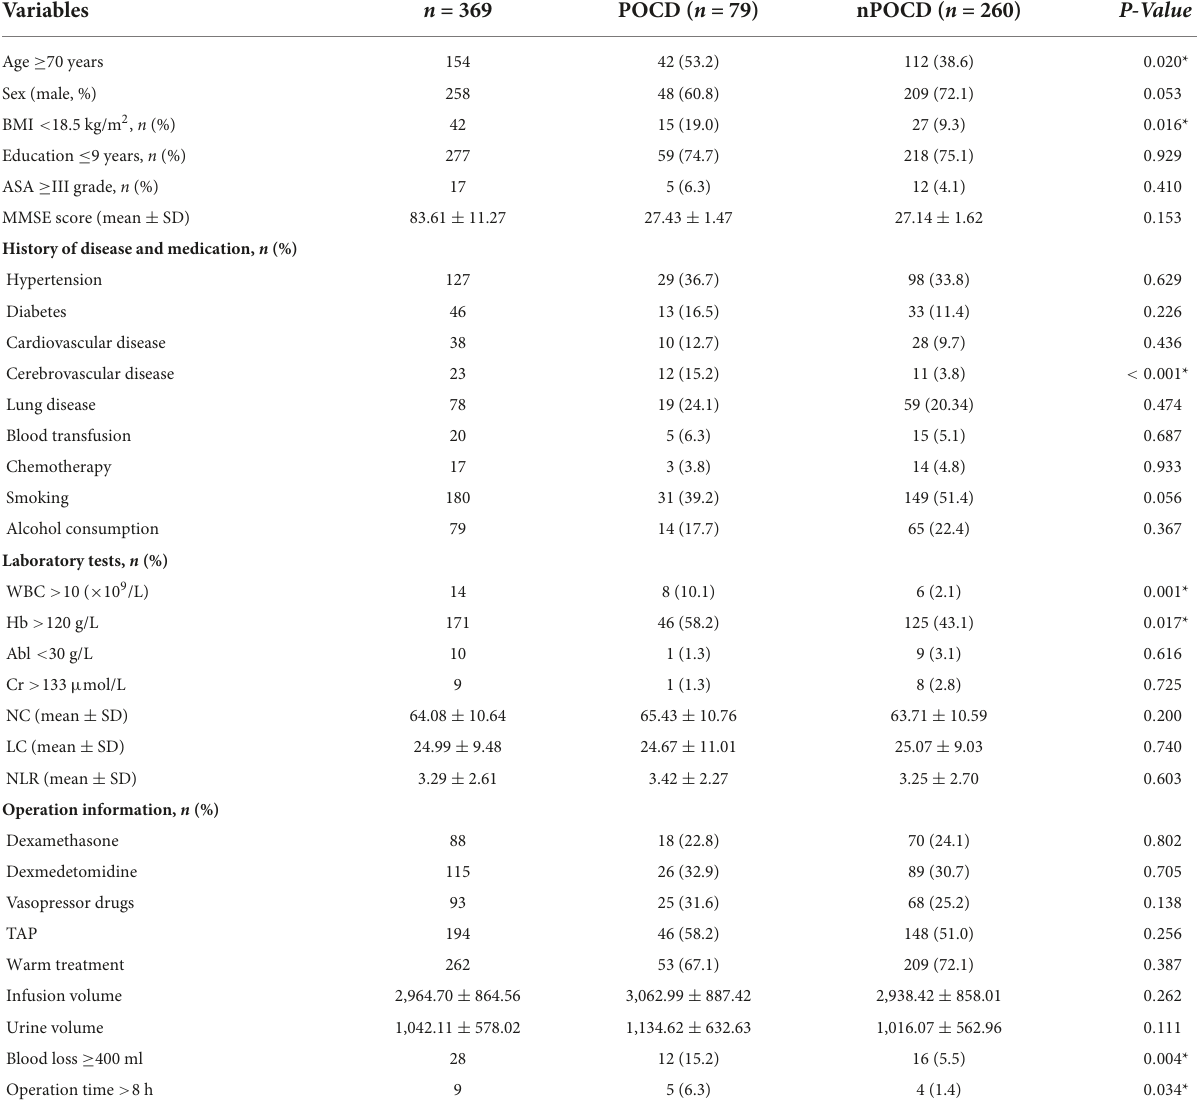
TABLE 1 Comparison of general data and perioperative data between the POCD group and the non-POCD